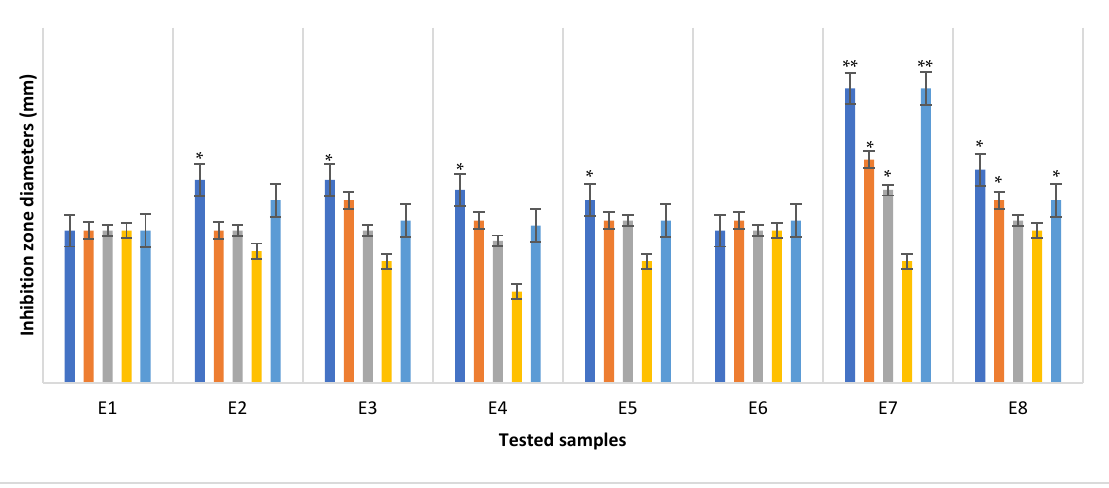
Figure 12. Graphical representation of the inhibition zone diameters yielded by the tested microbial strains after 20 h of contact with the samples E1–E8. Significant evidence of an inhibitory effect, expressed as the inhibition zone diameters, was noted as * for p < 0.05 and ** for p < 0.01. The qualitative tests showed that both the samples loaded with thyme essential